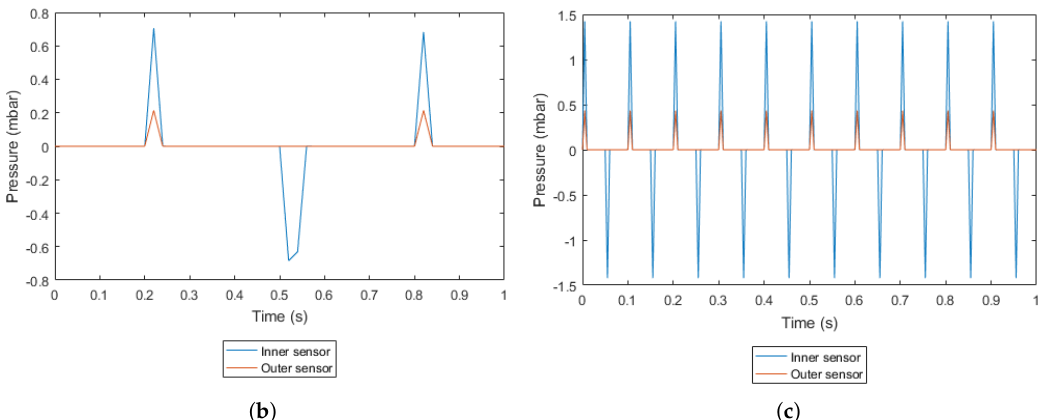
Figure 18. A comparison of the pressure profiles for the micropump [23]: The results for the ( a ) experimental, ( b ) numerical, and ( c ) new device proposed in the present paper. ( a ) The experimental results of the inner pressure sensor. From [23] (Reproduced under Creative Commons Attribution License; ( b ) The pressure profile obtained from the simulation; ( c ) The pressure profile obtained for the proposed device.